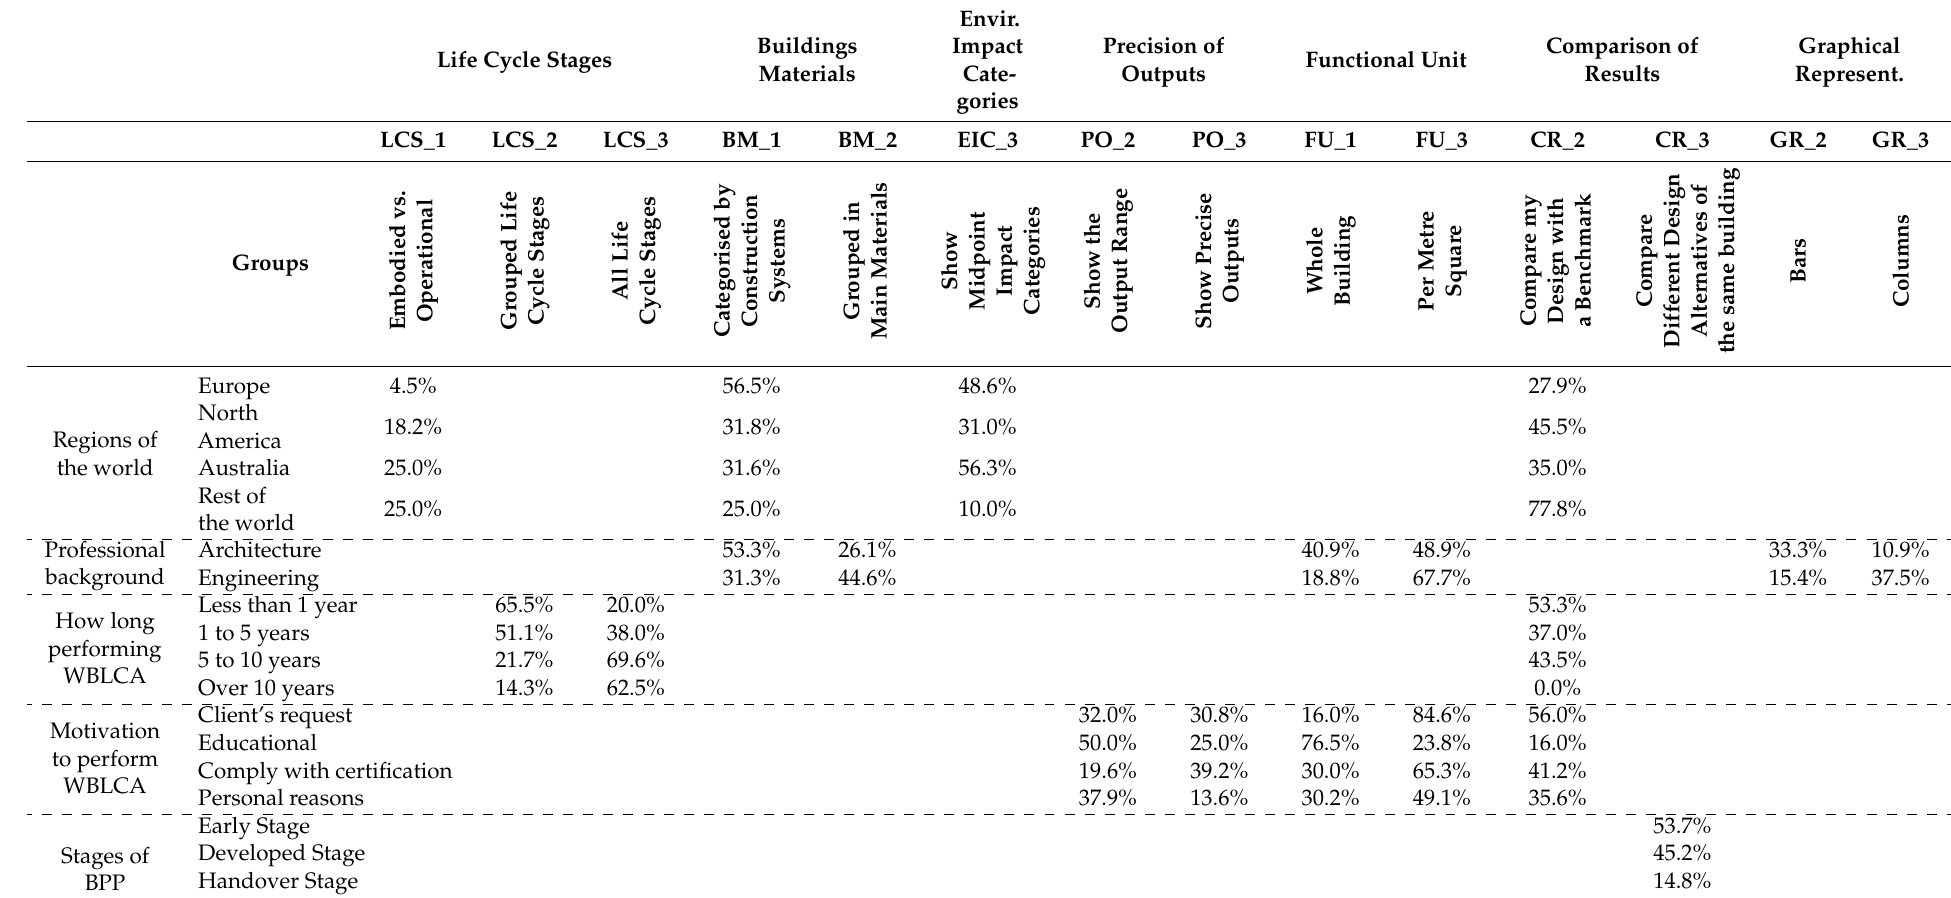
Table 8. Percentages of preferred outputs within different groups of independent variables. Life Cycle Stages